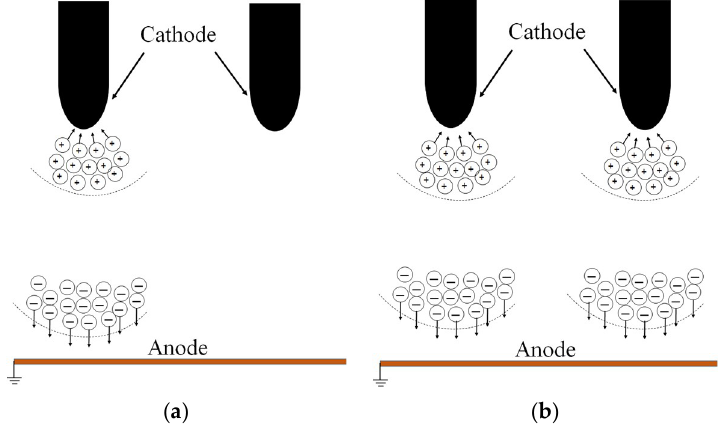
Figure 15. Double-needle Trichel pulse process: ( a ) Trichel pulse process under small applied voltage; ( b ) Trichel pulse process under large applied voltage. ( b ) Trichel pulse process under large applied